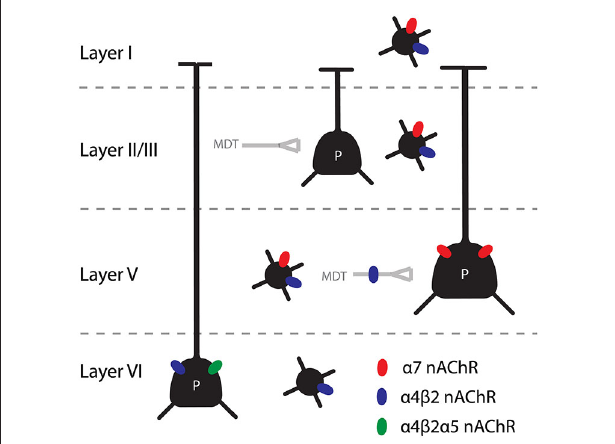
FIGURE 1 | Summary of the main findings concerning nAChRs in the mPFC. Pyramidal cells in layer V and VI are directly modulated by nicotinic receptors, through α 7 and β 2* nAChRs respectively. In addition, the thalamic input to layer V is heavily modulated by β 2* nAChRs. Interneurons in all layers contain nAChRs, although the distribution of homomeric and heteromeric receptor is different for different interneuron types and the different